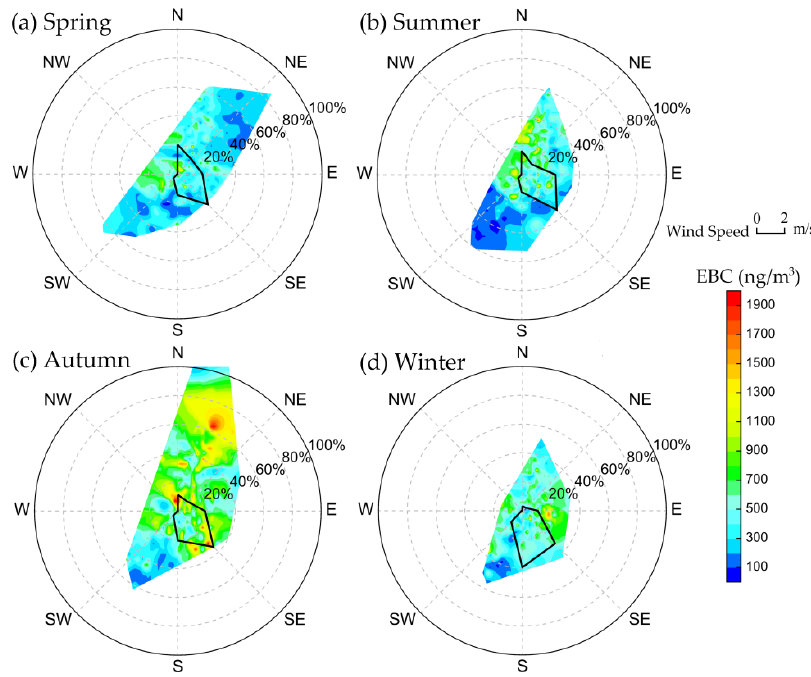
Figure 9. The relationship of average EBC concentration and winds in ( a ) Spring; ( b ) Summer; ( c ) autumn; ( d ) winter. Concentrations of EBC are given by the color bar. The frequency of wind direction is shown by the black line.